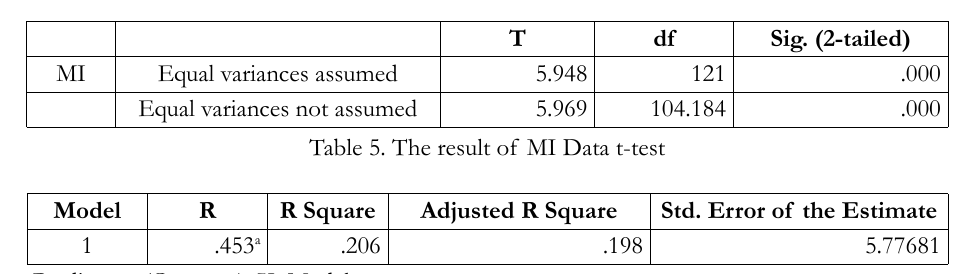
Table 6. The Summary of Linear Regression